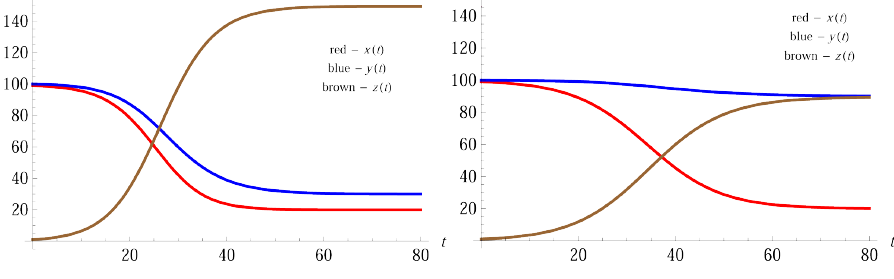
Figure 1. Time series of system (3): n = b vs. n > b ( a = 2 . 73973 · 10 − 6 , c = 0 . 0015 , m = 0 . 0000328767 , p = 0 . 001; left: b = n = 0 . 03 , d = 0 . 0600466 , right: b = 0 . 03 , n = 0 . 09 , d = 0 . 120047; initial conditions: x 0 = 99; y 0 = 100; z 0 =